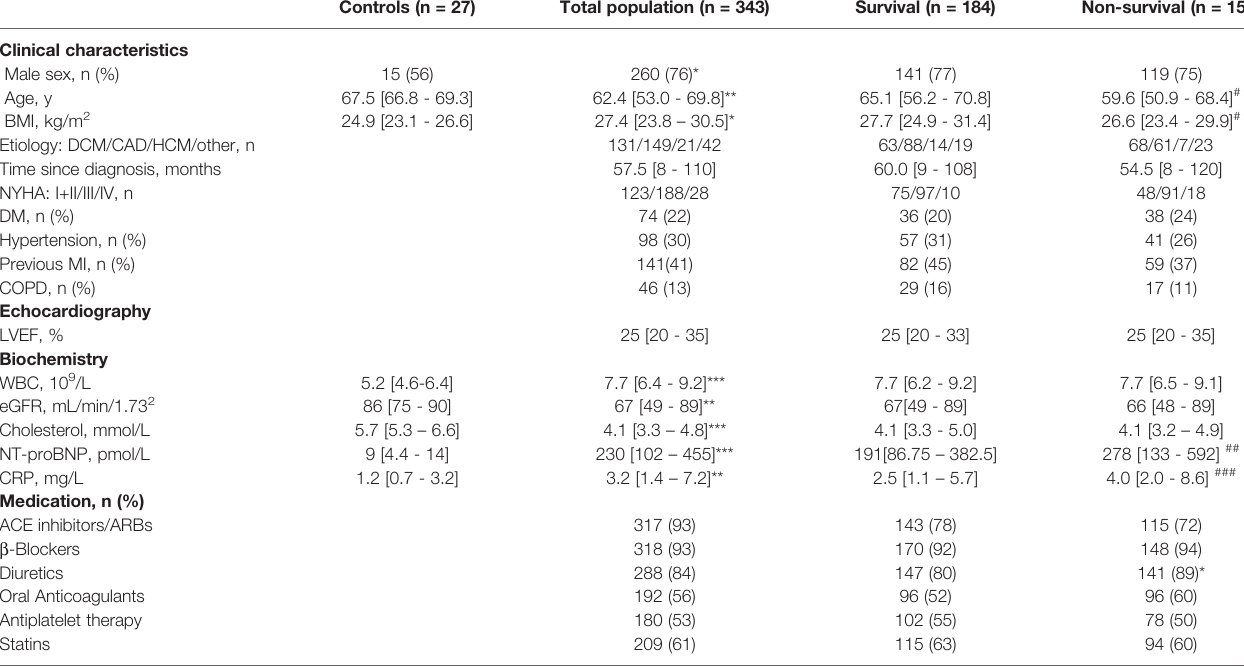
TABLE 1 | Characteristics of the study